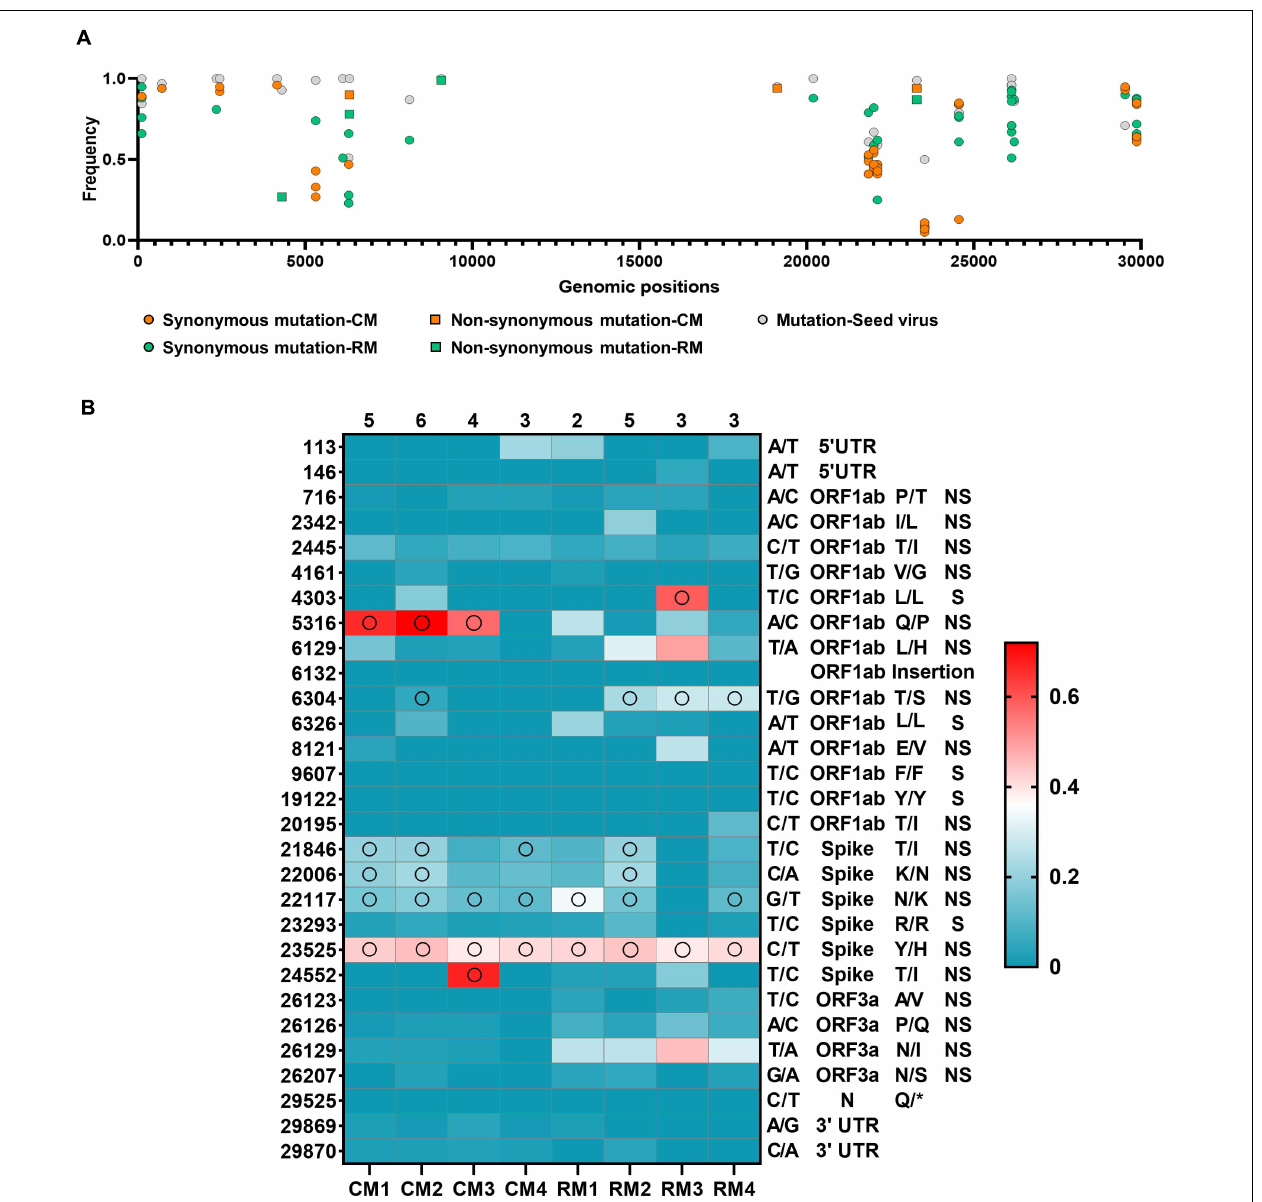
FIGURE 3 | Mutation frequency in the SARS-CoV-2. (A) Frequency variant profiles within the whole SARS-CoV-2 genome. The mutations of major allele frequency of seed virus were described at the consensus level. (B) Changes in frequency rates of corresponding alleles at each position in SARS-CoV-2 isolates compared to the reference alleles of the seed virus. Reference allele/substitute allele at the nucleotide position, gene name, amino acid variation (reference/substitute), and mutation type (non-synonymous, synonymous) are shown to the right of the heat map. Open circles represent consensus variants at this position. The total number of consensus changes in each sample is shown above